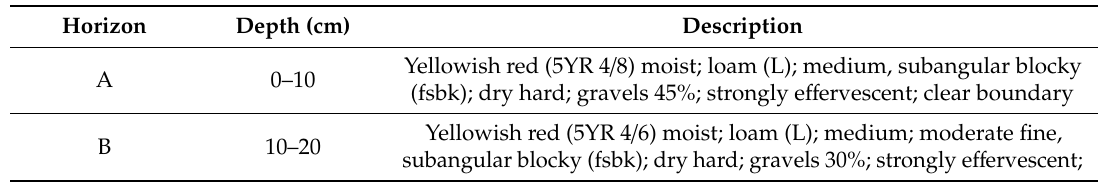
Table A23. Profile P4 horizons